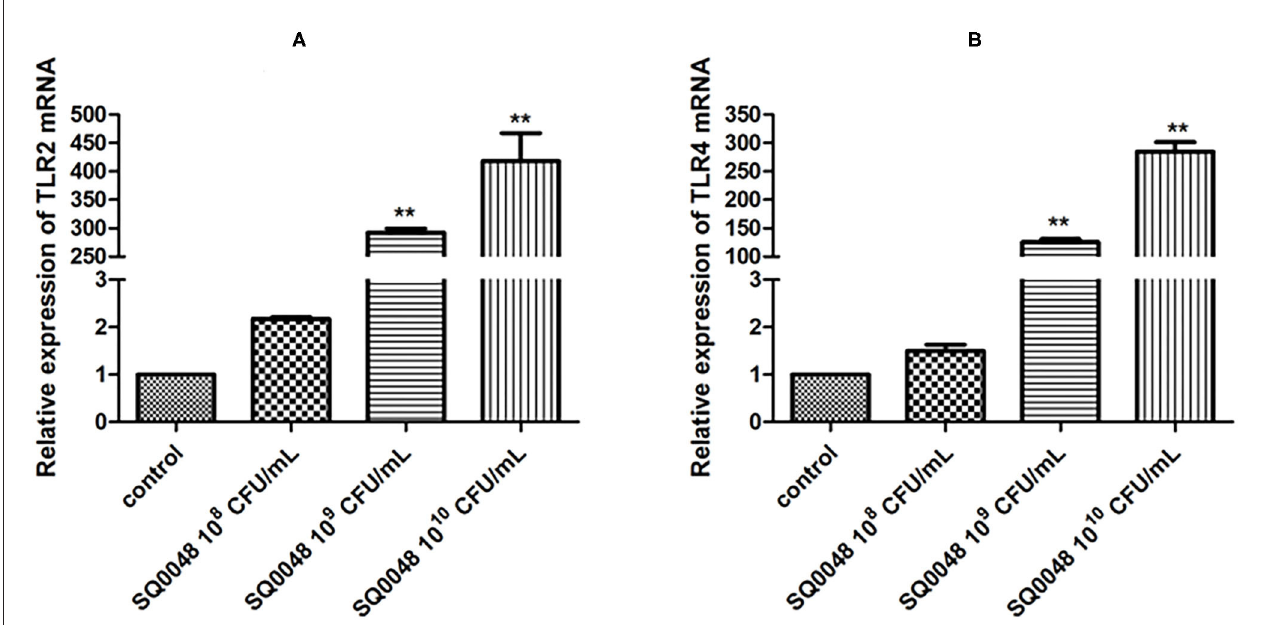
FIGURE 1 | Effects of SQ0048 on mRNA expression levels of TLR2 (A) and TLR4 (B) in BVECs. All data are shown as means ± SD ( n = 3). * P < 0.05 and ** P < 0.01 relative to